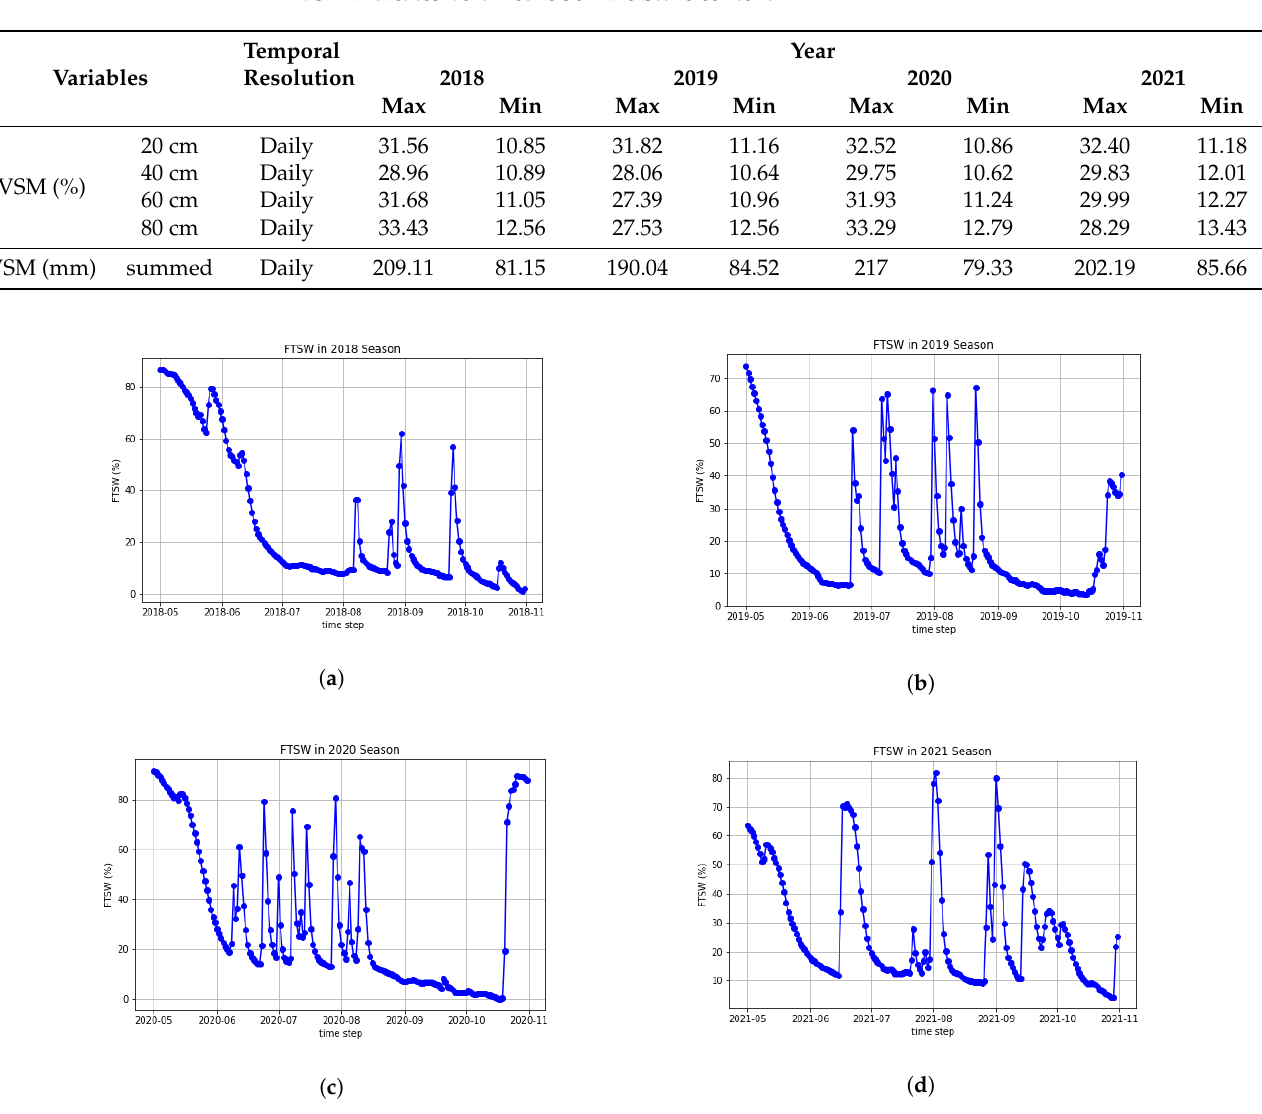
Table 2. Soil moisture data details for each season (from April to October) from Colinas do Douro. VSM indicates Volumetric Soil Moisture content.